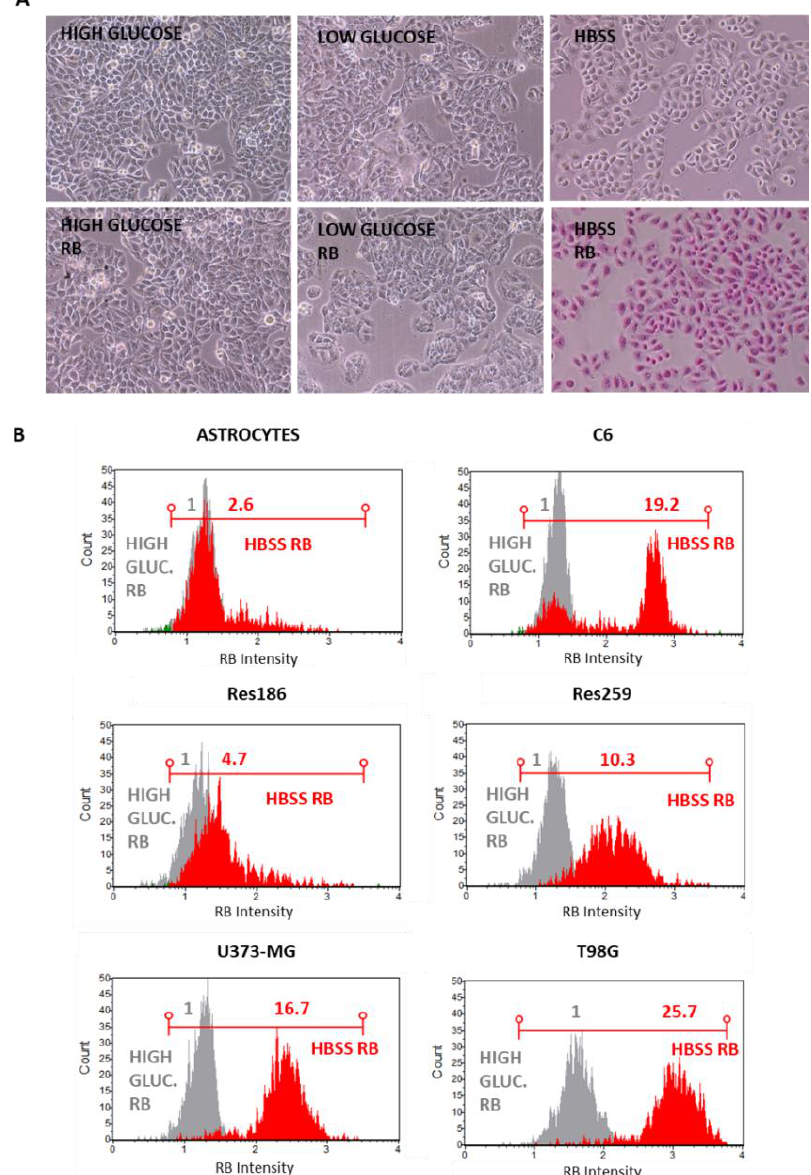
Figure 4. Amino acids starvation-induced uptake of RB in different cell lines. ( A ) T98G cells were incubated or not for 24 h with RB (12.5 μM) in standard DMEM high glucose (D-glucose = 4500 mg/L), DMEM low-glucose (D-glucose = 1000 mg/L) or HBSS amino acids-depleted media and visualized after 24 h p.t. using a Nikon Eclipse TS100 inverted microscope at 10× magnification. NT = RB untreated cells in standard high glucose medium. ( B ) Similar RB incubation experiments were performed in normal rat astrocytes, rat C6 glioma, low- (Res186-Res259) and high-grade astrocytoma cells (U373-MG and T98G). After incubation, cells were trypsinized and analyzed for RB fluorescence intensity using the Guava Muse Cell Analyzer (Luminex, Laser = 532 nm; Filter = 576 ± 14 nm). Each plot was obtained analyzing 5000 cells and normalized to the corresponding RB intensity in standard high glucose (RB = 1) and compared to fold differences in HBSS RB conditions.